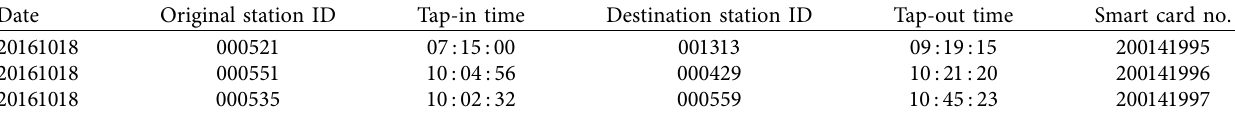
Table 1: Necessary elements of AFC data.